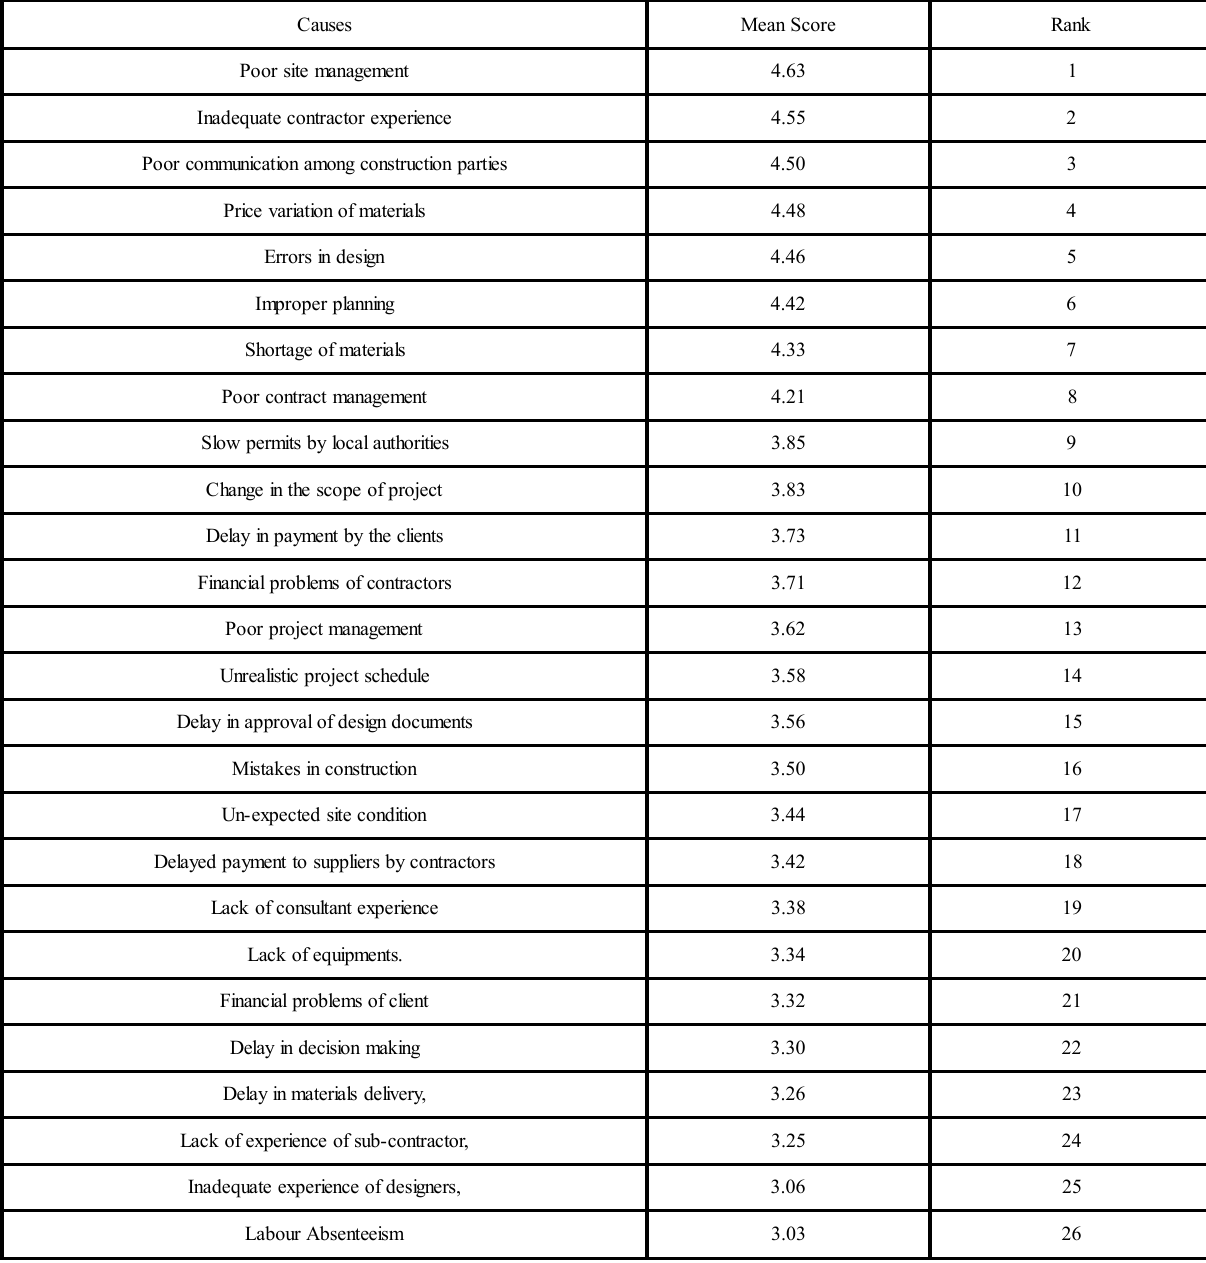
TABLE 5. RANKING OF CAUSES OF DELAY IN HIGHWAY PROJECTS